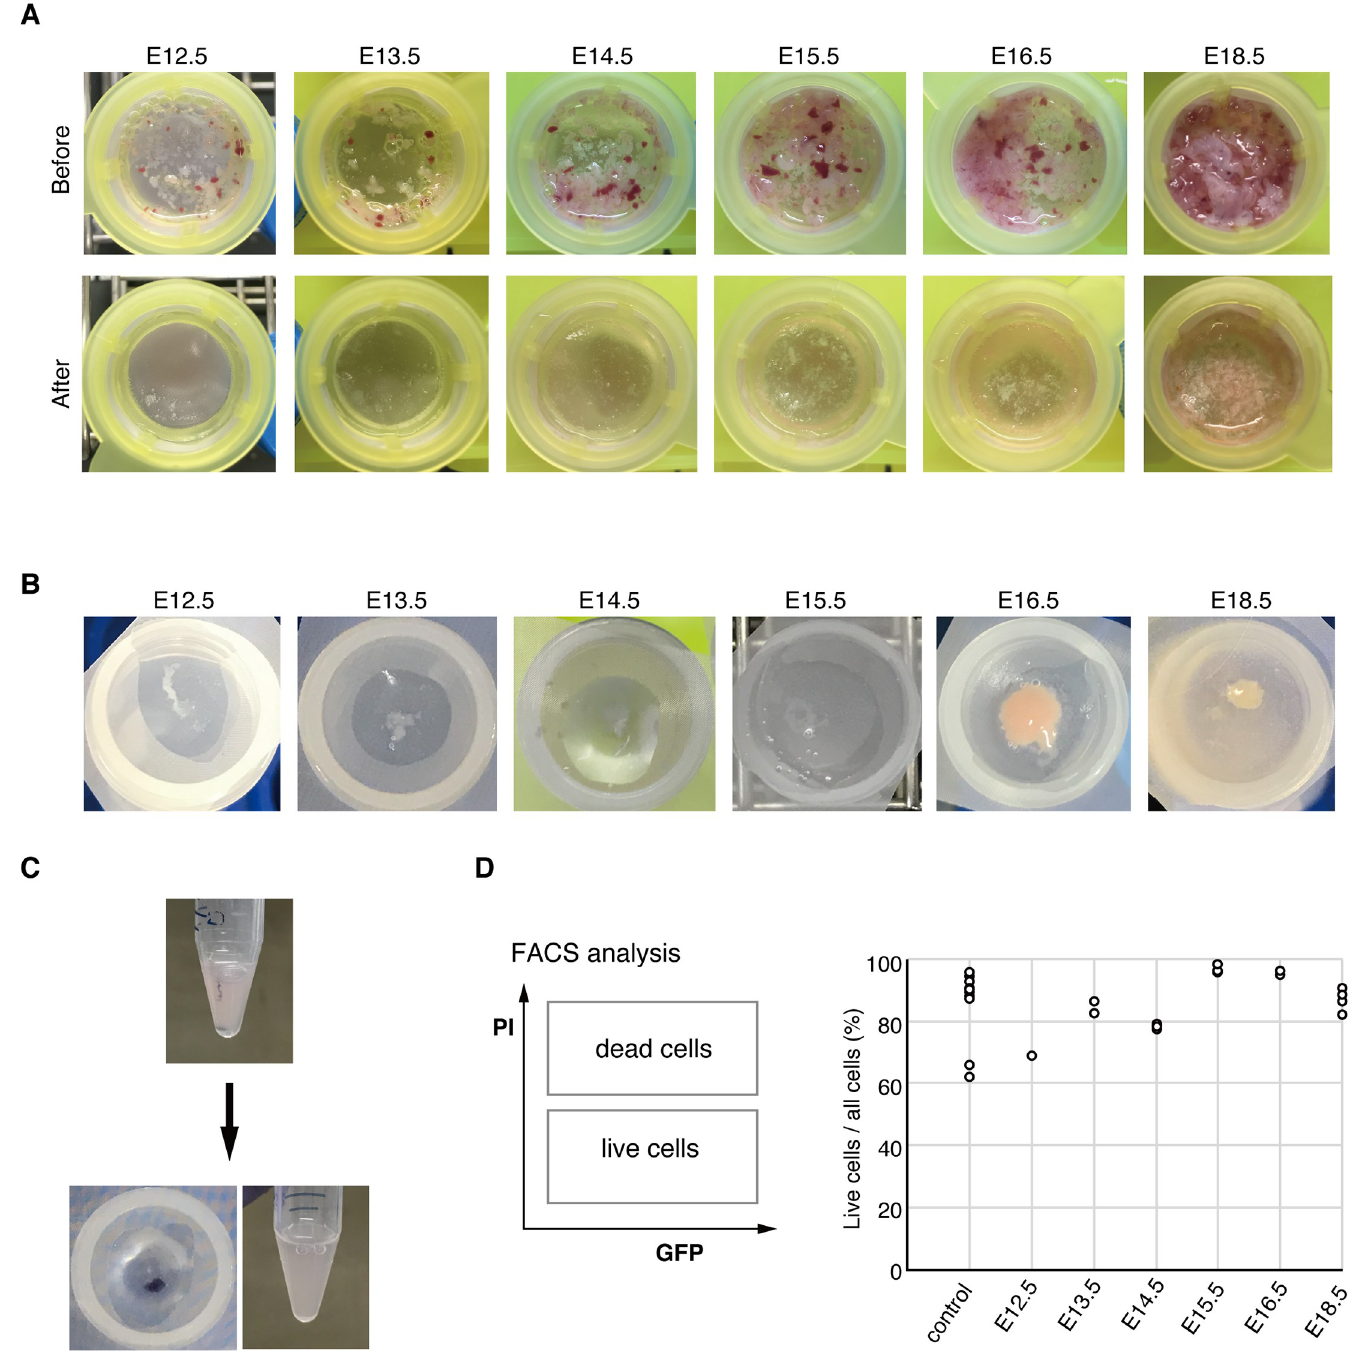
Fig 2. Dissociation of cells by filtration and survival rate of isolated cells. (A) Minced samples before and after the rough filtration are shown for each developmental stage. A 100- μ m cell strainer was used for the rough filtration. Note that more aggregates remained in samples from the later stages E16.5 and E18.5. (B) Samples after fine filtration with the 70- μ m cell strainer. (C) Rough filtered samples were stained with trypan blue, and finer filtration was performed to estimate whether the aggregates were mainly composed of dead cells. (D) Live cell rate in each developmental stage. Calculation of live cell rate (%) in the cell suspensions was evaluated using PI marker (dead cell marker) and FACS. The control sample originated from an adult spleen. Each circle represents the ratio of live cells in a single sample. [control: n = 11, E12.5: n = 1 (68.8%), E13.5: n = 2 (median 84.3%), E14.5: n = 5 (median 78.4%), E15.5: n = 4 (median 97.0%), E16.5: n = 2 (median 95.4%), E18.5: n = 4 (median